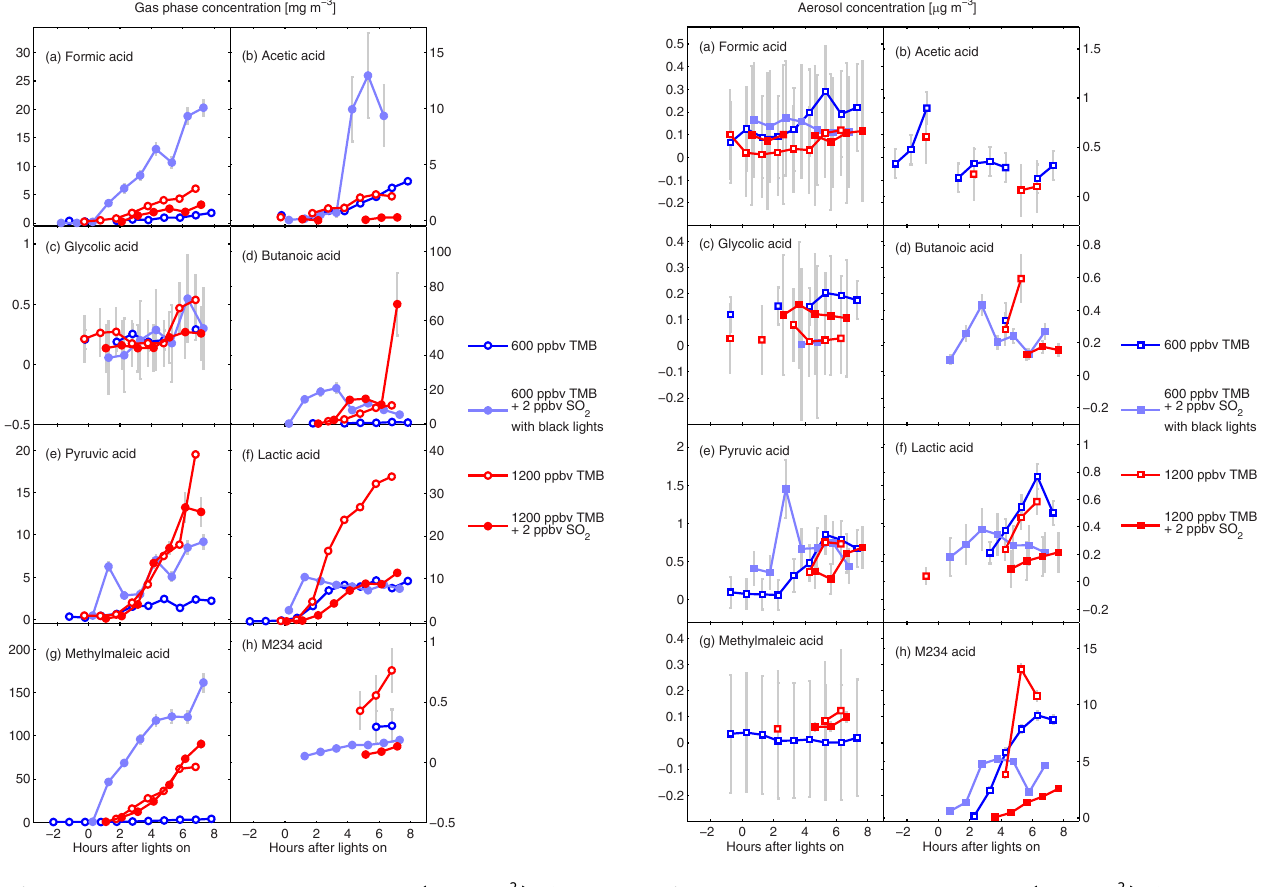
Figure 6. Gas phase concentration profiles (in µgm − 3 ) of eight measured organic acids. Filled symbols: with SO 2 ; open symbols: without SO 2 ; red: high conc.; blue: low conc. Error bars in grey are derived from calibration curves and sampling flow uncertainties.